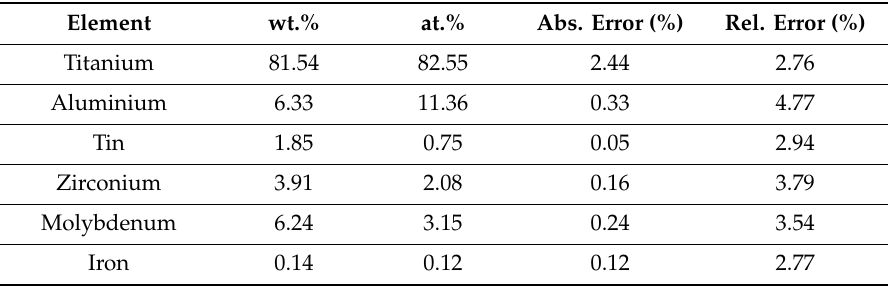
Table 1. Chemical composition of as-received (AR) Ti-6246